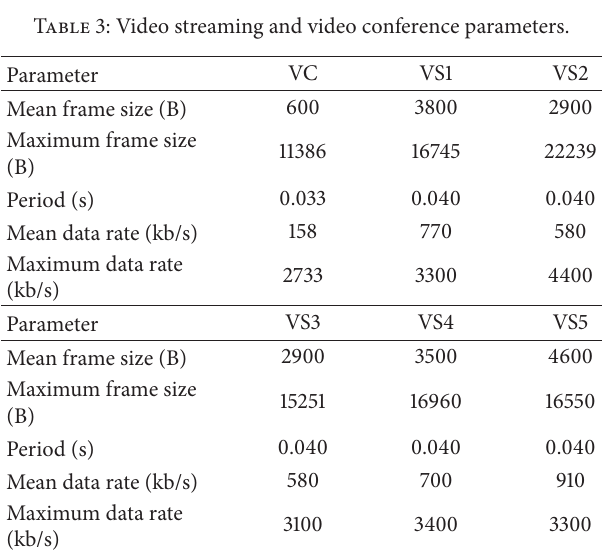
Table 3: Video streaming and video conference parameters.